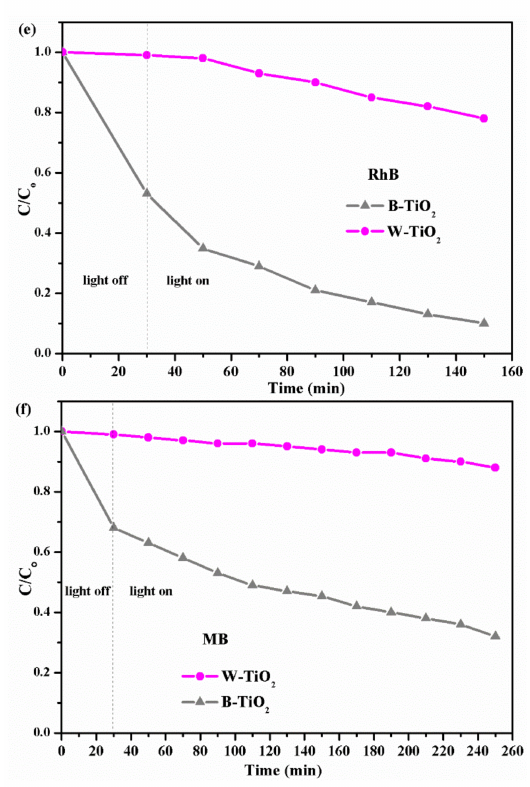
Figure 7. Comparison of photodecomposition of RhB ( a ) and MB ( c ) with different photocatalysts under UV light. − ln(C/C 0 ) of the RhB ( b ) and MB ( d ) concentration as a function of UV light irradiation time. Photodecomposition of RhB ( e ) and MB ( f ) with different photocatalysts under visible